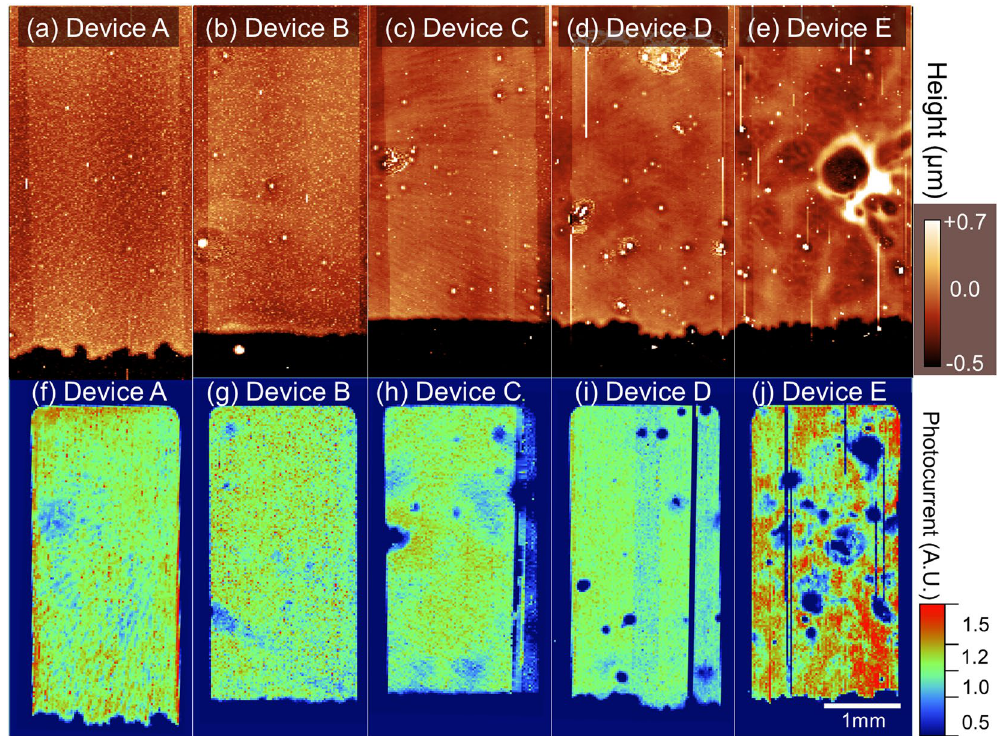
Figure 4. Topographic images of device A–E (parts ( a–e )) measured by scanning profilometry with colour and lateral scales shown inset in part ( a ) and ( e) respectively. LBIC (laser beam induced current mapping) maps of Devices A to E shown in parts ( f ) to ( j ). Data has been normalised to the average photocurrent and represented on the same colour scale. All images are plotted on the same lateral scale shown inset in part ( j ).